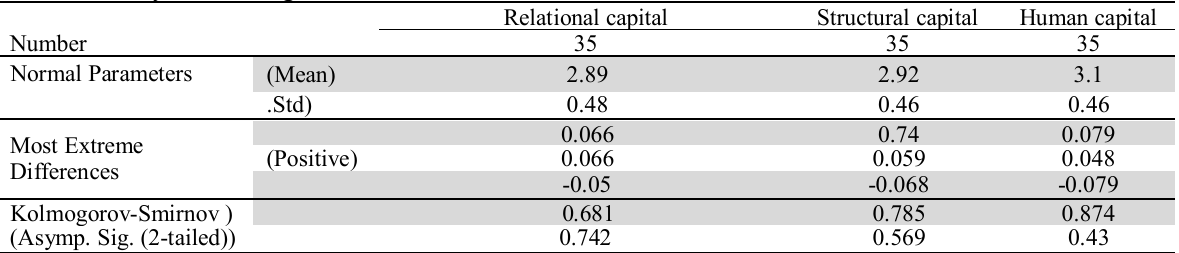
Relational capital